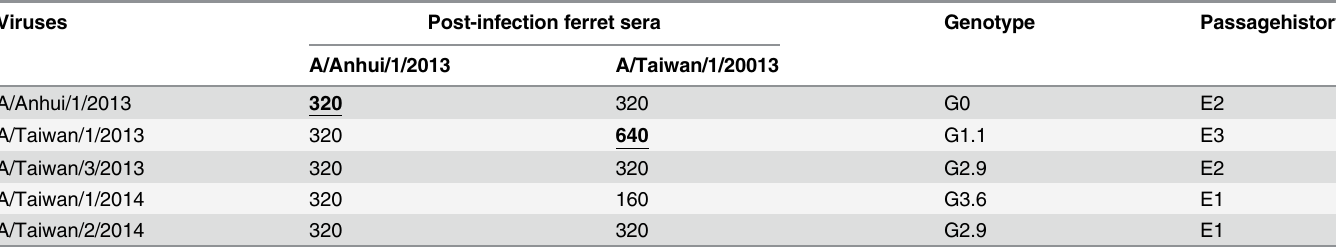
Table 3. Antigenic analysis of the four imported H7N9 viruses by hemagglutination inhibition assay.